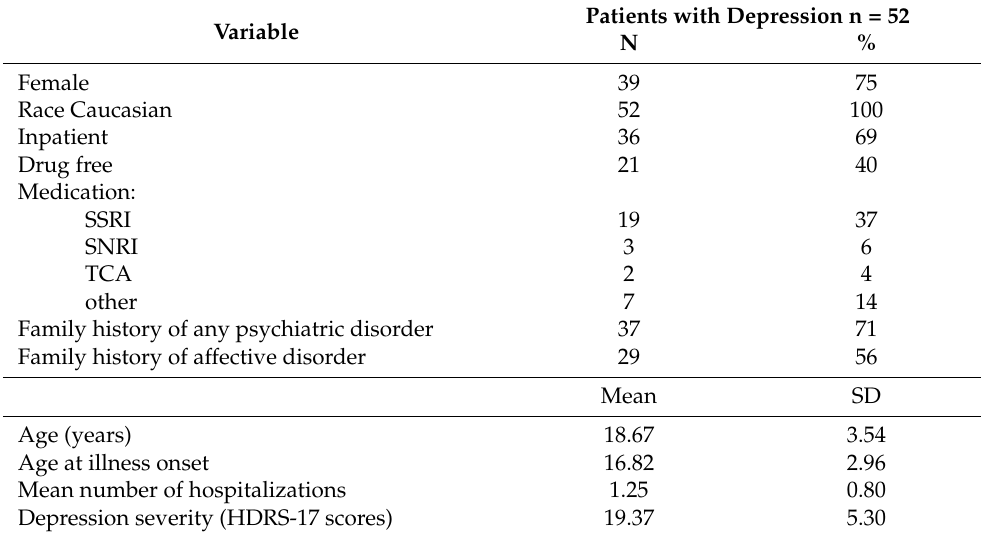
Table 1. Characteristics of the study sample.